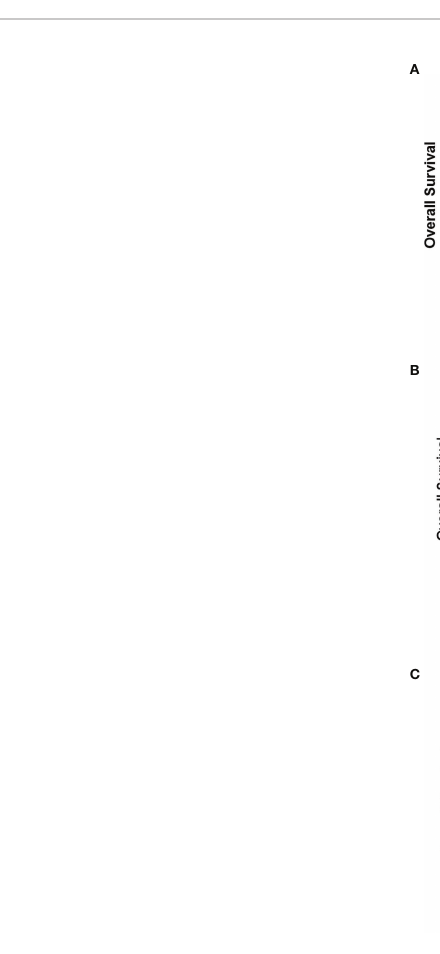
FIGURE 7 | Kaplan-Meier curves of overall survival between the chemotherapy and non-chemotherapy cohort in the low-risk group ( A P =0.025), median-risk group ( B P < 0.001) and high-risk group ( C P <